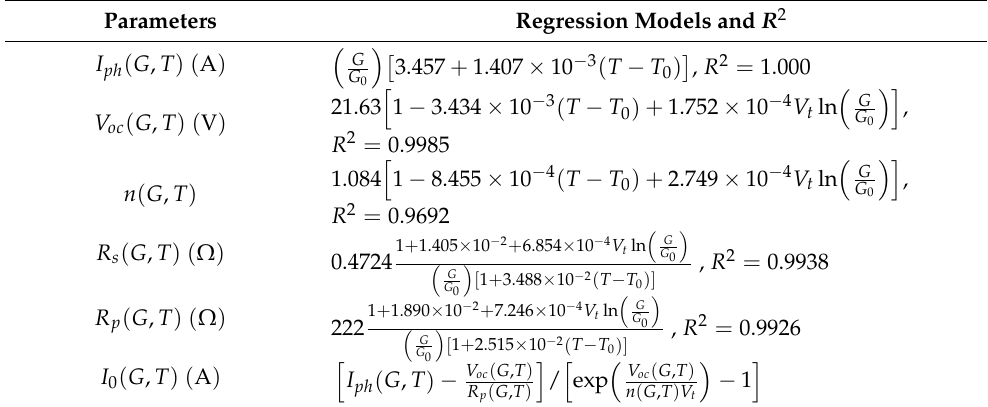
Table 1. Regression model and R 2 for parameters estimated from experimental